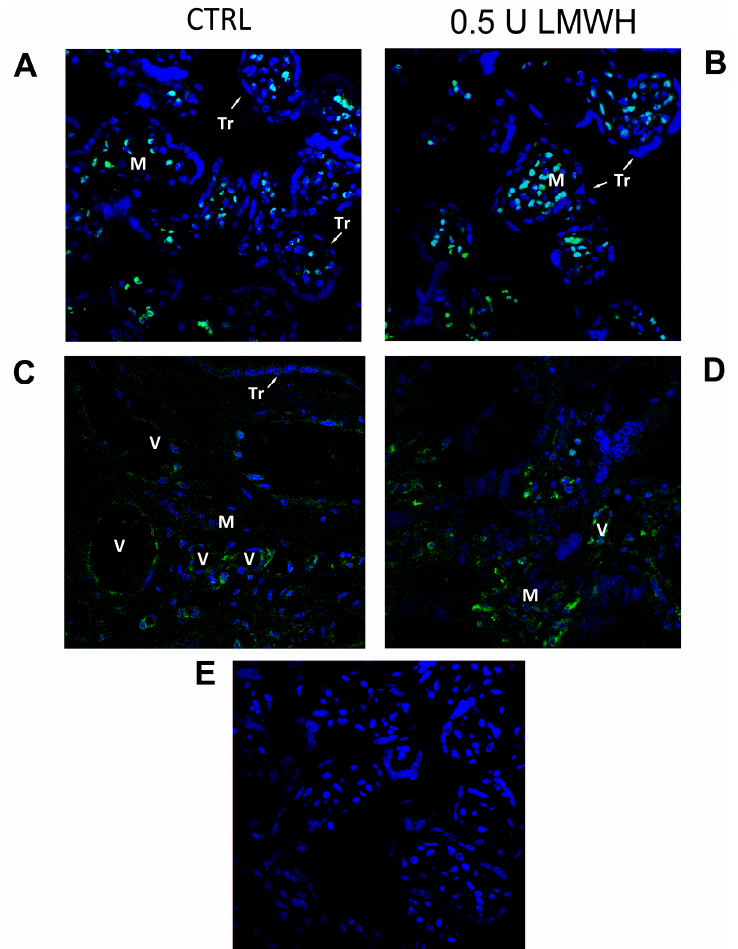
Figure 5. HMGB1 spatial localization in untreated or 0.5 U LMWH treated physiological villous explants assessed by immunofluorescent staining. ( A – C ) HMGB1 spatial localization in untreated (n = 6) physiological villous explants assessed by immunofluorescent staining; ( B – D ) HMGB1 spatial localization in physiological villous explants treated with 0.5 U of LMWH (n = 6); ( E ) Absence of positive immunoreactivity for HMGB1 in section stained with control IgG. Cell nuclei are showed in blue by DAPI signal. TR, trophoblast cells; M, mesenchyme; V, vessel. Original magnifications, 60×.